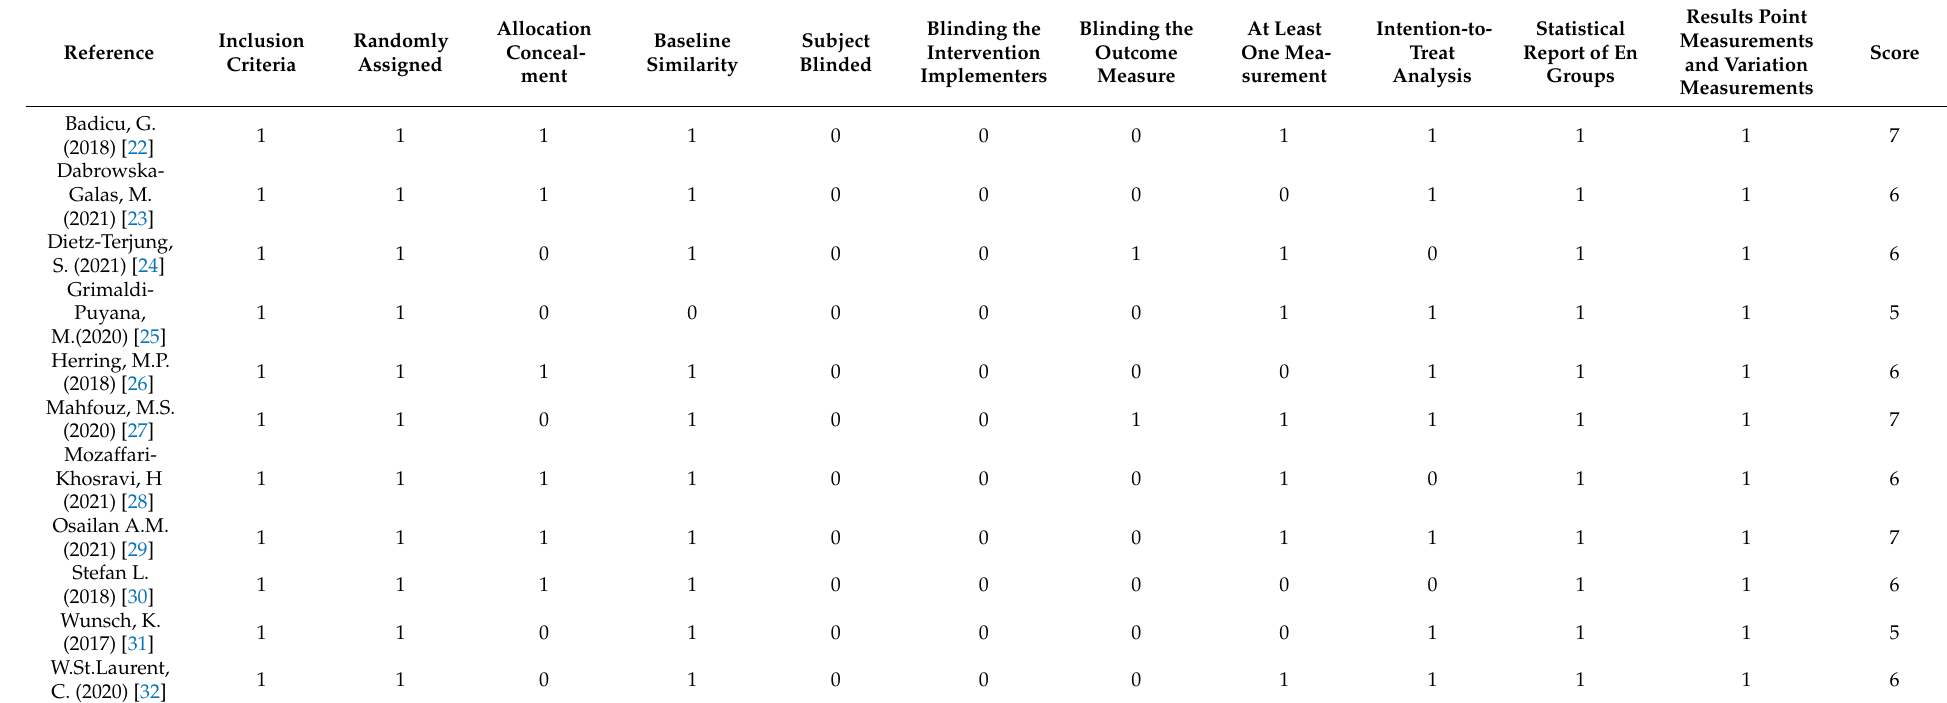
Table 1. PEDro score of the included